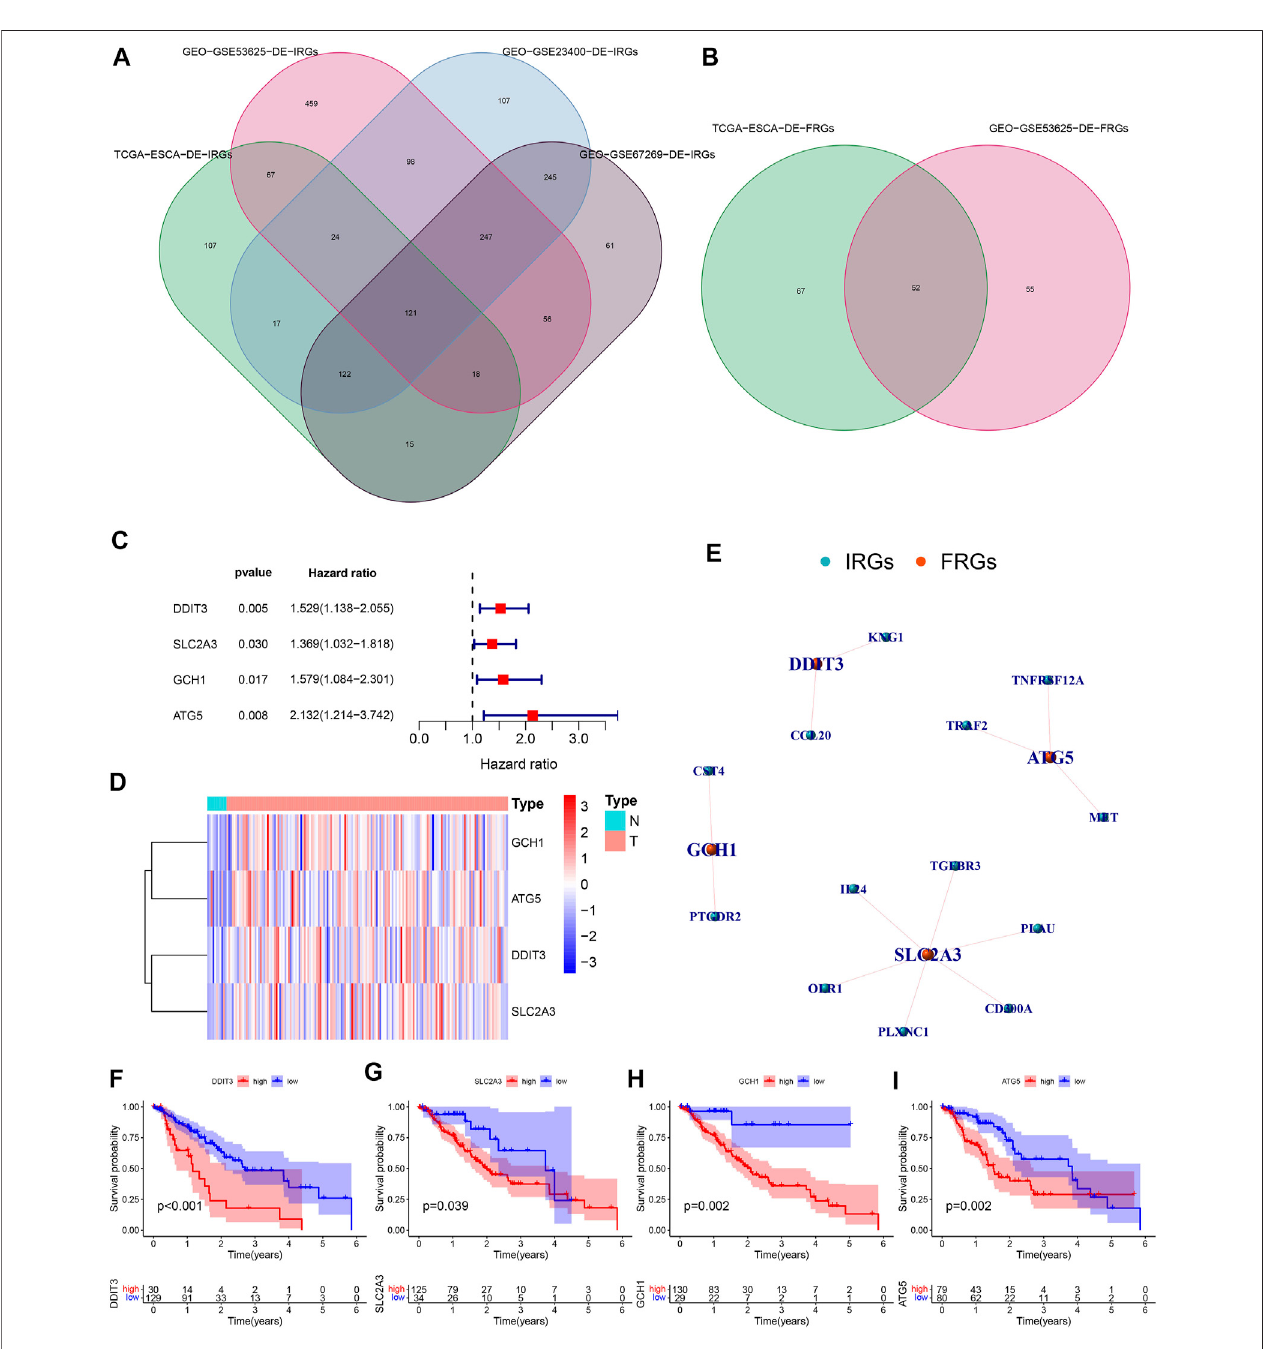
FIGURE 2 | Recognition of PR-DE-IRFeGs. (A – B) Genes shared among database samples of DE-IRGs and DE-FRGs. The database samples refer to TCGA and GEO. (C) Forest plot of univariate Cox regression analysis of 4 PR-DE-IRFeGs. Hazard ratio is obtained by running single factor and multi-factor cox regression. (D) The heat map shows the expression status of 4 PR-DE-IRFeGs in tumor and standard cases. (E) The co-expression network between 4 PR-DE-IRFeGs and the corresponding DE-IRGs. (F – I) Survival differences between the high and low expression groups that correspond to the four PR-DE-IRFeGs.